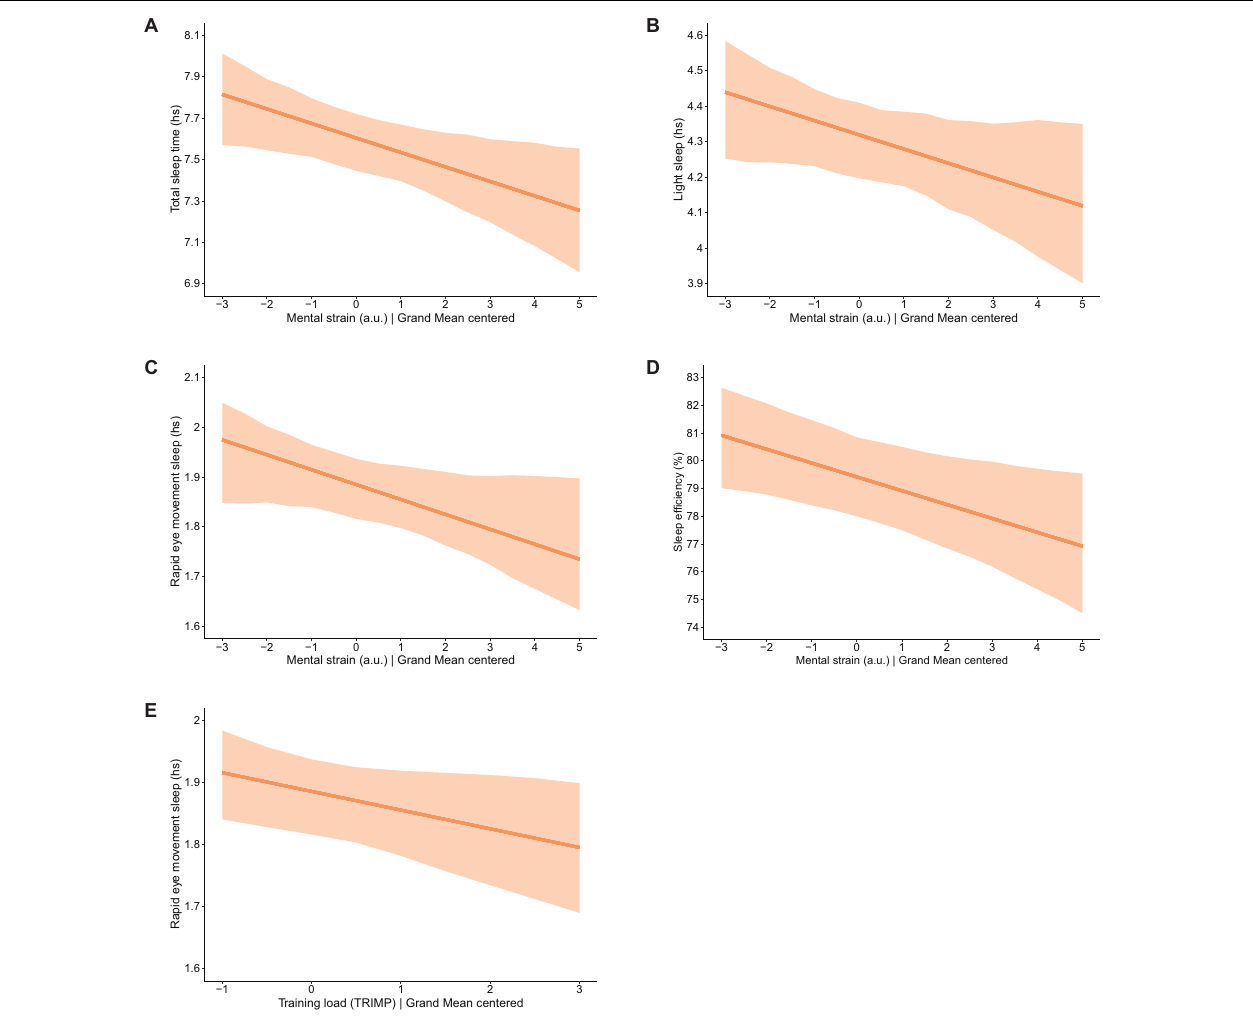
FIGURE 4 | Significant findings identified when testing the same-day effects of mental strain and training load on sleep in 56 junior endurance athletes: (A) effect of mental strain on total sleep time, (B) effect of mental strain on light sleep, (C) effect of mental strain on rapid eye movement sleep, (D) effect of mental strain on sleep efficiency, and (E) effect of training load on rapid eye movement sleep. The bold line represents the average intercept and slope identified in the given models. The shaded area above the line represents the upper 2.5% of 95% credibility interval, while the shaded area below the line represents the lower 2.5% of 95% credibility interval. Value 0 on the x -axis refers to the average value on the measured outcome